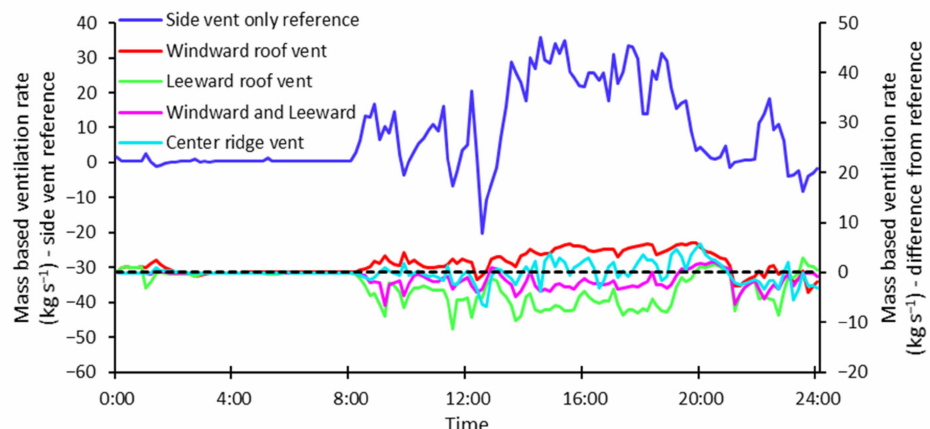
Figure 8. Mass-based ventilation rate at the leeward roll-up side vent for the different roof vent designs evaluated. The primary y-axis represents the actual air flow rates for the side vent only design as a reference. The right axis represents the air flow rates at the leeward roll-up side vents of the other designs subtracted by the side vent only reference (positive values mean higher air flow rates relative to the reference